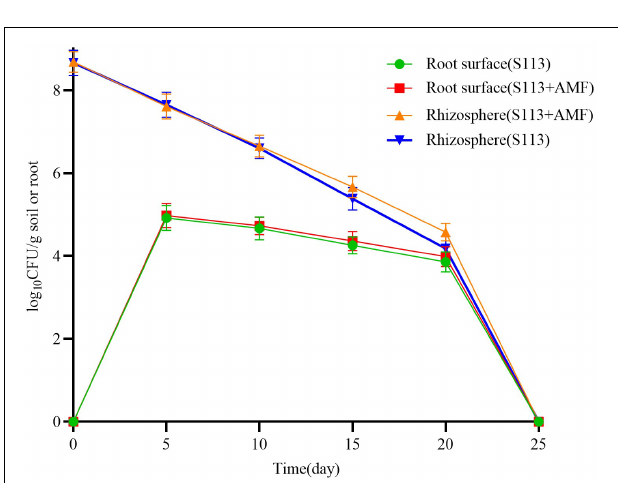
FIGURE 3 | Effects of Arbuscular mycorrhizal fungi (AMF) on the colonization of S113 in the rhizosphere and root surface. Dynamic of S113 population on roots surface and in the rhizosphere of maize under different treatments. The data are shown as log 10 CFU per gram soil or roots. The error bars indicate standard deviations for three samples.